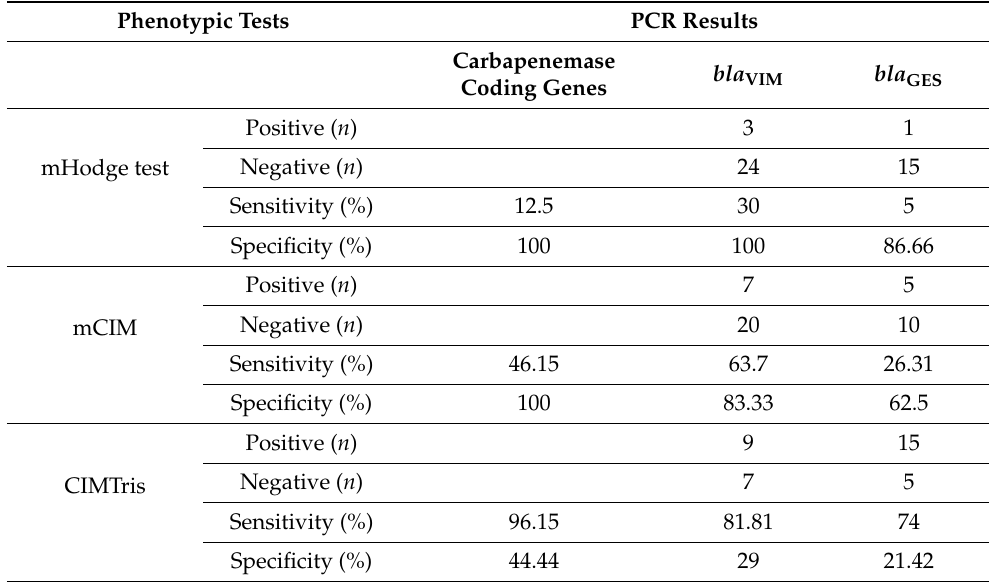
Table 6. Comparison of three phenotypic methods for carbapenemase detection in Pseudomonas aeruginosa strains according to carbapenemase encoding